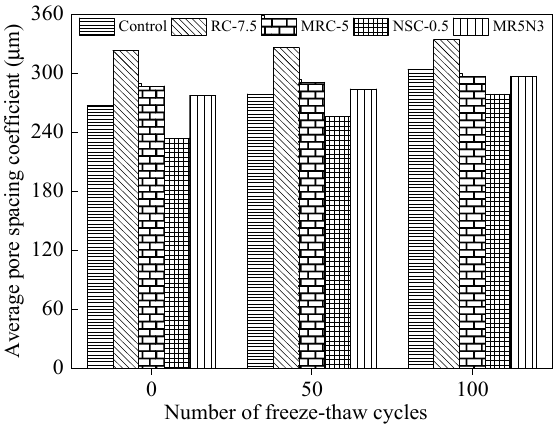
Figure 16. Influence of freeze–thaw cycle on average pore spacing coefficient.